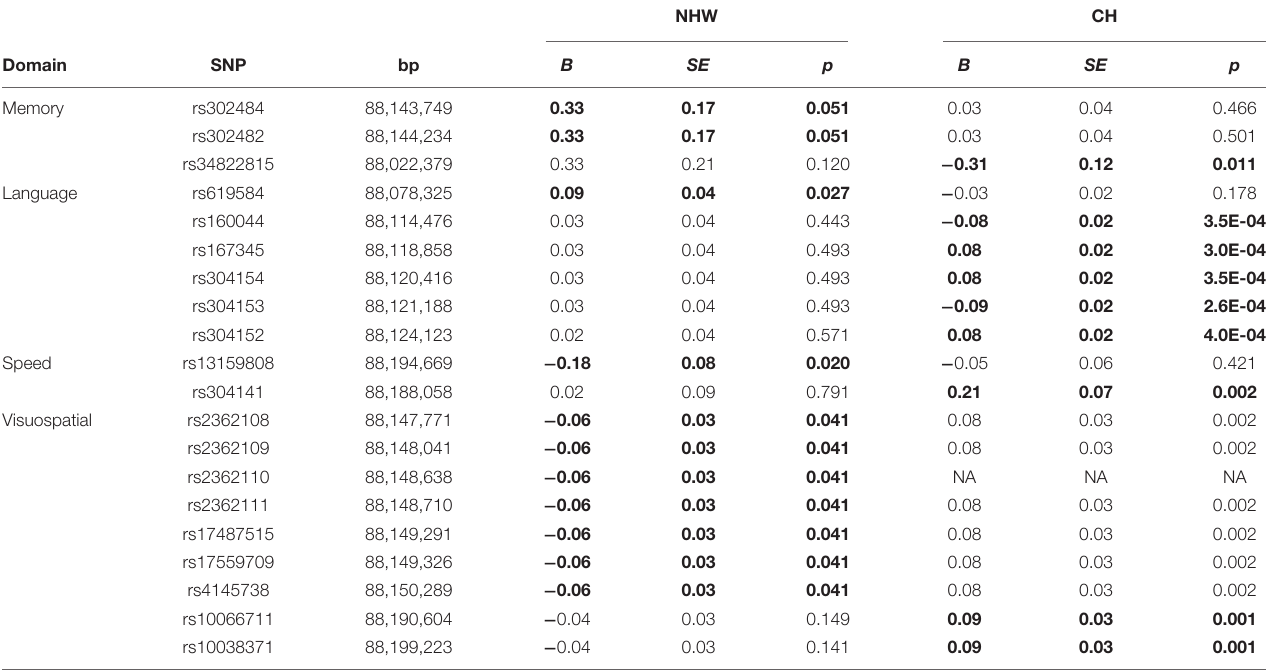
TABLE 2 | Top nominal significant SNPs associations within each cognitive domain for Non-Hispanic White and Caribbean Hispanic participants.